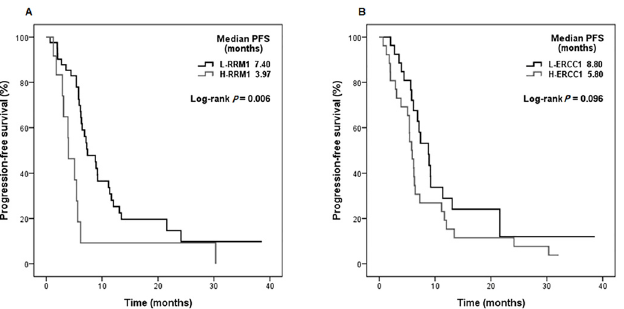
Fig 2. Progression-free survival of patients according to biomarker expression for (A) ribonucleotide reductase subunit M1 (RRM1), (B) excision crosscomplementing gene-1 (ERCC1).